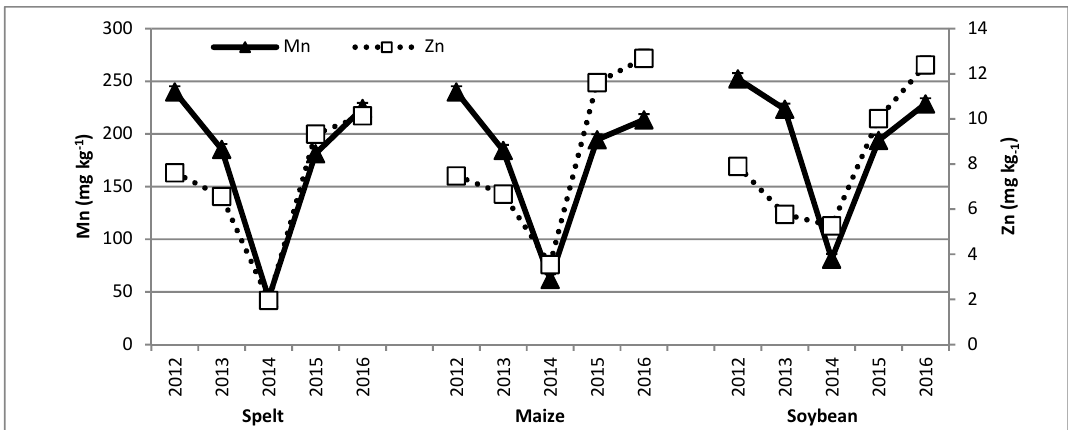
Figure 5. The status of available Mn and Zn in soil, across seasons, under organic production (bars represent SD values).